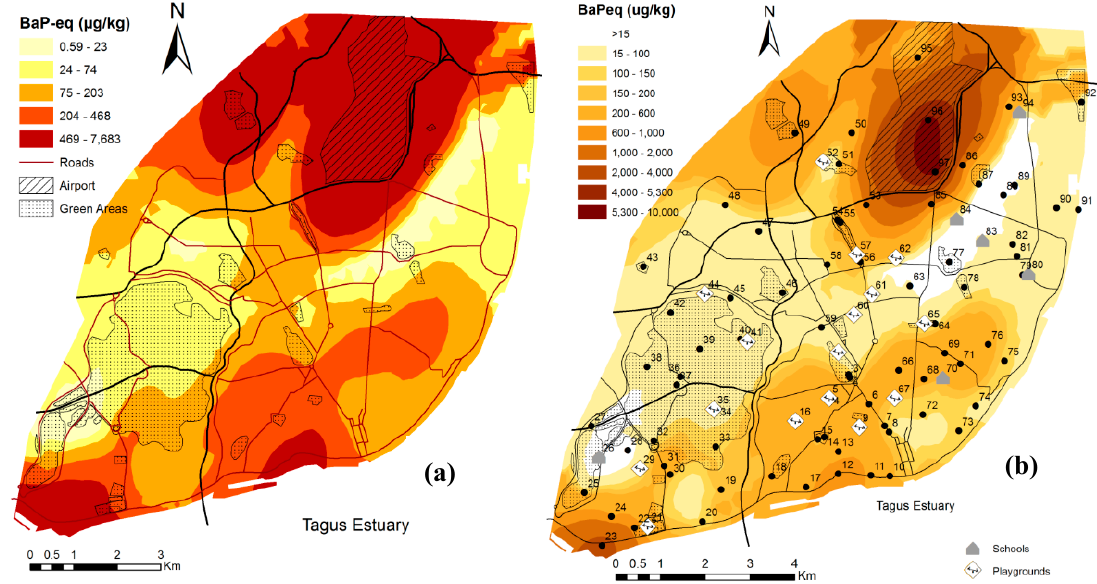
Figure 5. Contour map for SumBAPeq levels in Lisbon area, which was interpolated by ordinary kriging; the class limits correspond to the minimum, the quartiles (25, 50, and 75), the upper outlier limit, and the maximum value ( a ), and considering the different guideline values for human health protection ( b ).